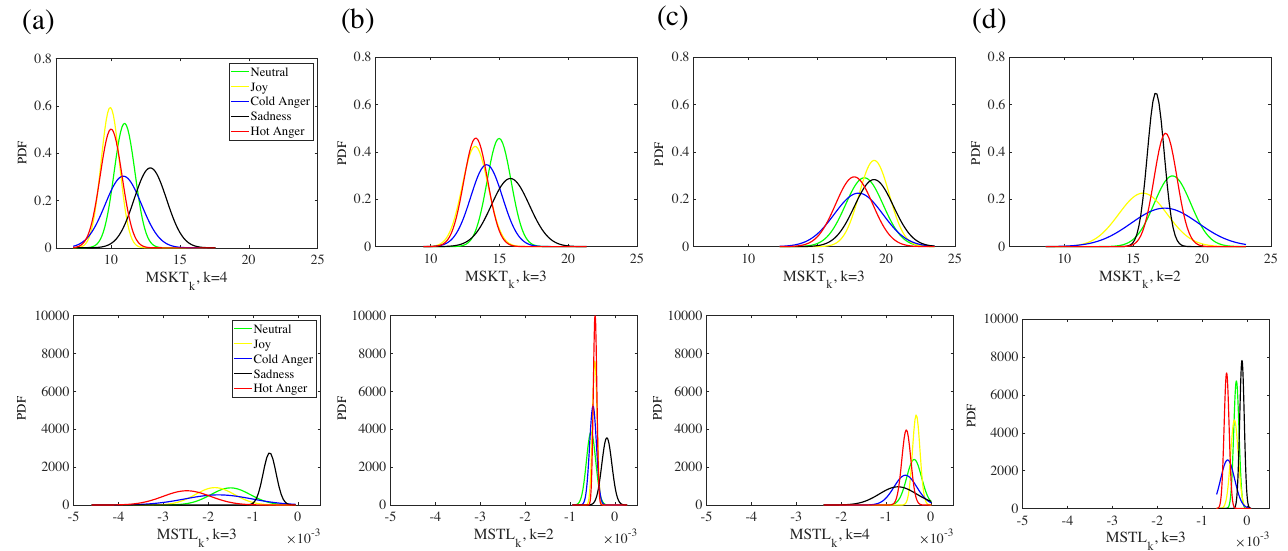
Figure 11. PDFs of MSKT k and MSTL k for each emotion in noisy/reverberant/noisy reverberant environments. Only MSFs with highest similarity are shown: ( a ) clean environment [15], ( b ) noisy environment (SNR = 5 dB), ( c ) reverberant environment ( T R = 1.0 s), and ( d ) noisy reverberant environment (SNR = 10 dB, T R = 0.5